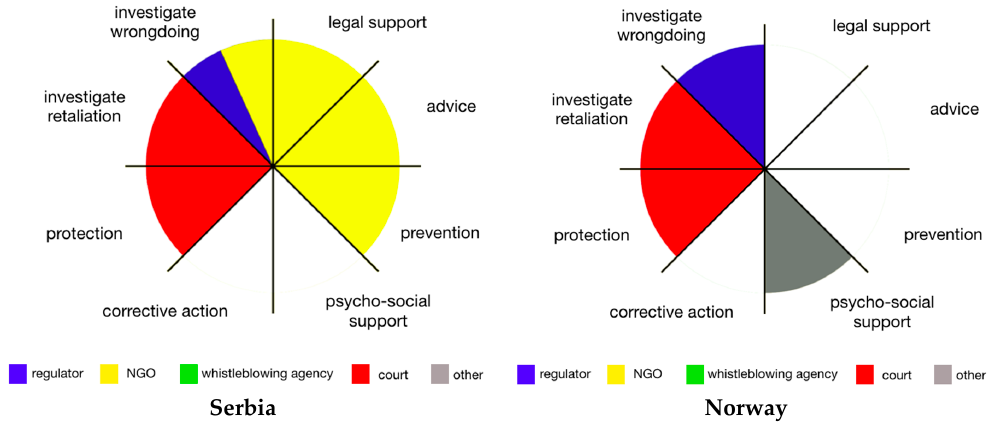
Figure 2. Agencies involved in whistleblowing in Serbia and Norway.